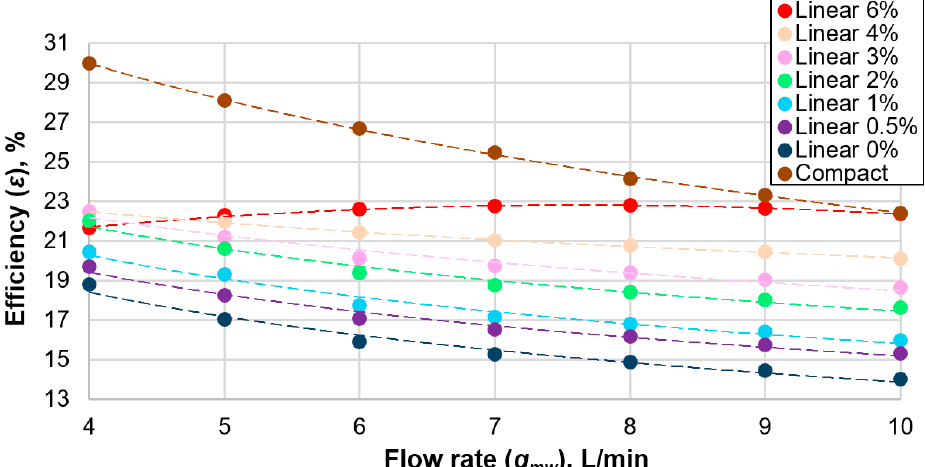
Figure 9. Efficiency of the shower heat exchangers determined for T cw = 18 °C.